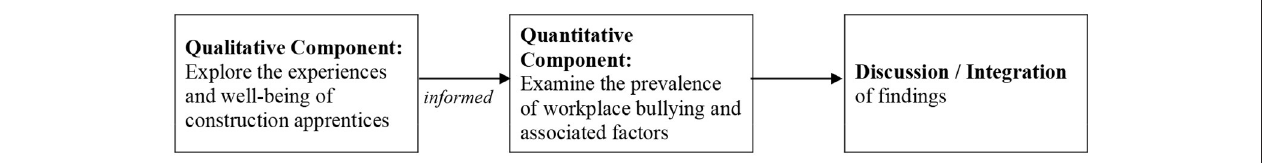
FIGURE 1 | Methodological overview of the exploratory sequential mixed methods